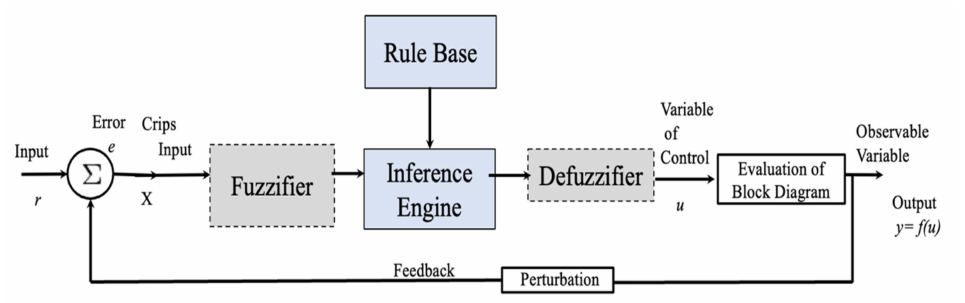
Figure 12. T1FLS applied in a